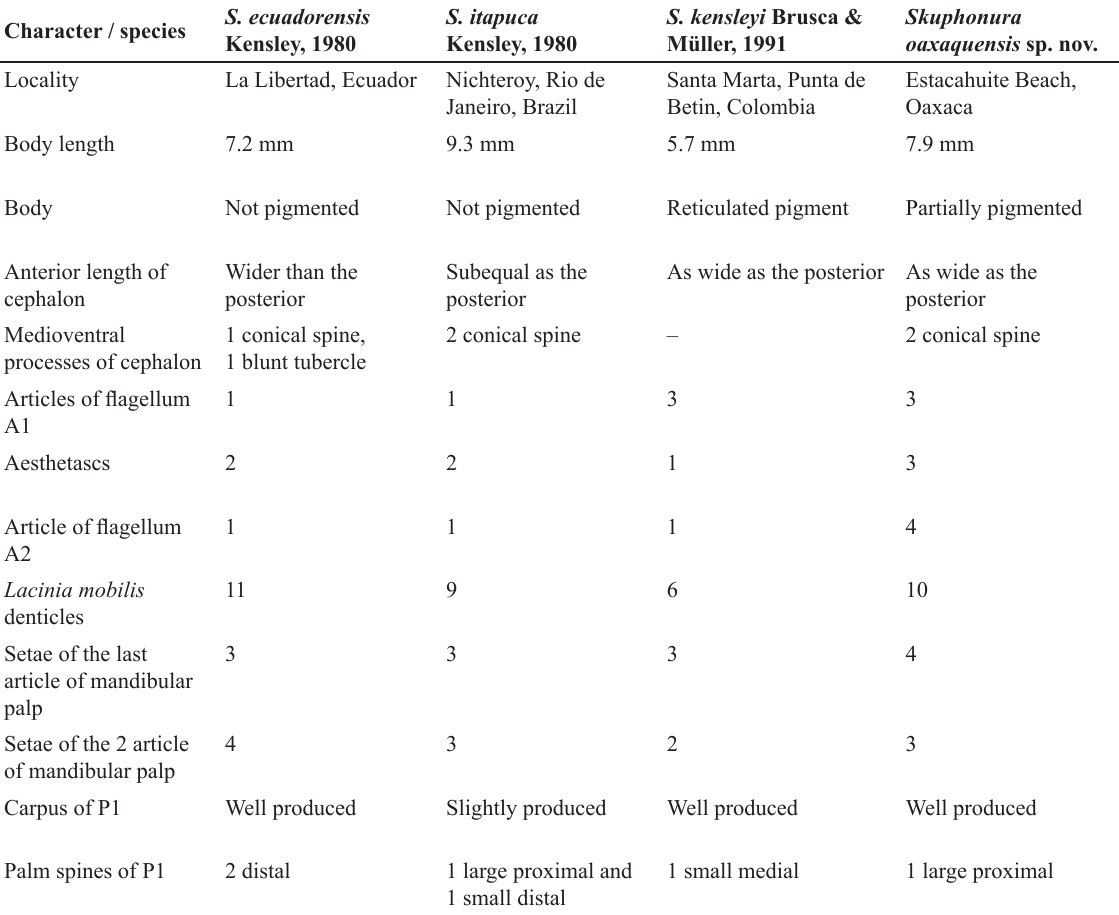
Table 2. Comparison between Skuphonura oaxaquensis sp. nov. and the closest species of